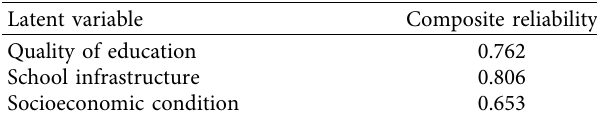
Table 4: Composite